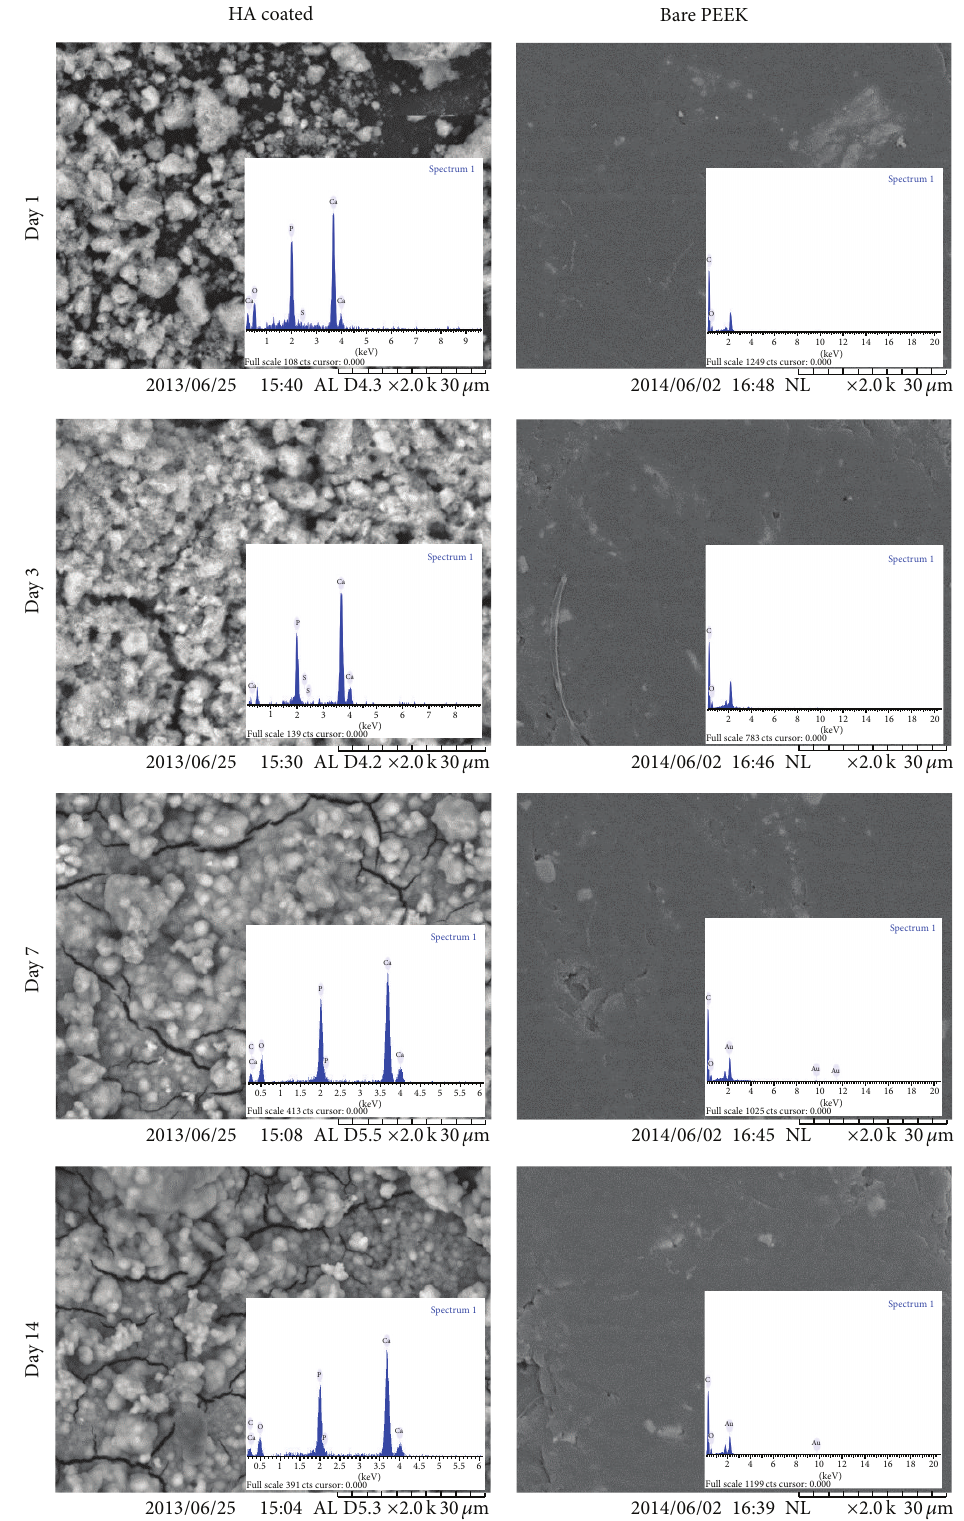
Figure 1: SEM images of the apatite formation on the PEEK samples with and without coating